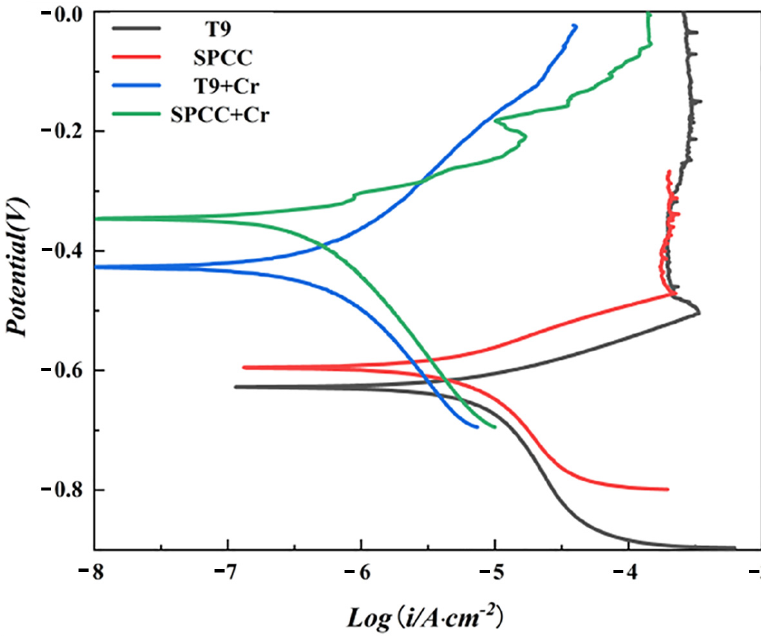
Figure 8. Polarization curves of the T9 steel, SPCC steel substrate, and the samples after chromizing in a 3.5 wt.% NaCl solution.